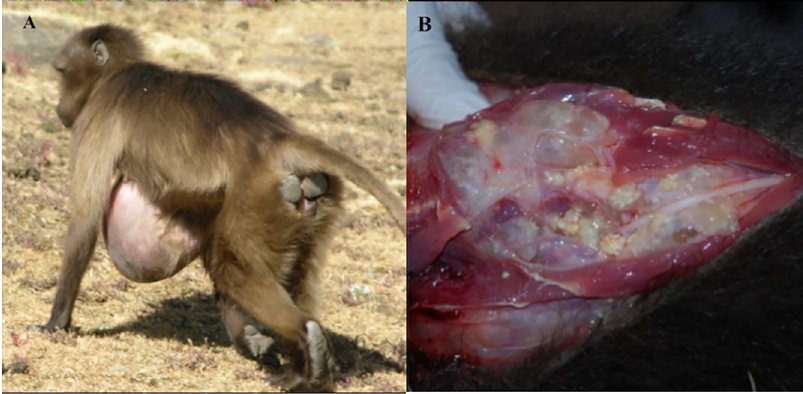
Fig 1. (A) Gelada with a cyst characteristic of confirmedlarval T . serialis infectionsprotrudingfrom the abdomen. (B) Internal view of coenuri in the cyst of an infected individual necropsieduponnatural